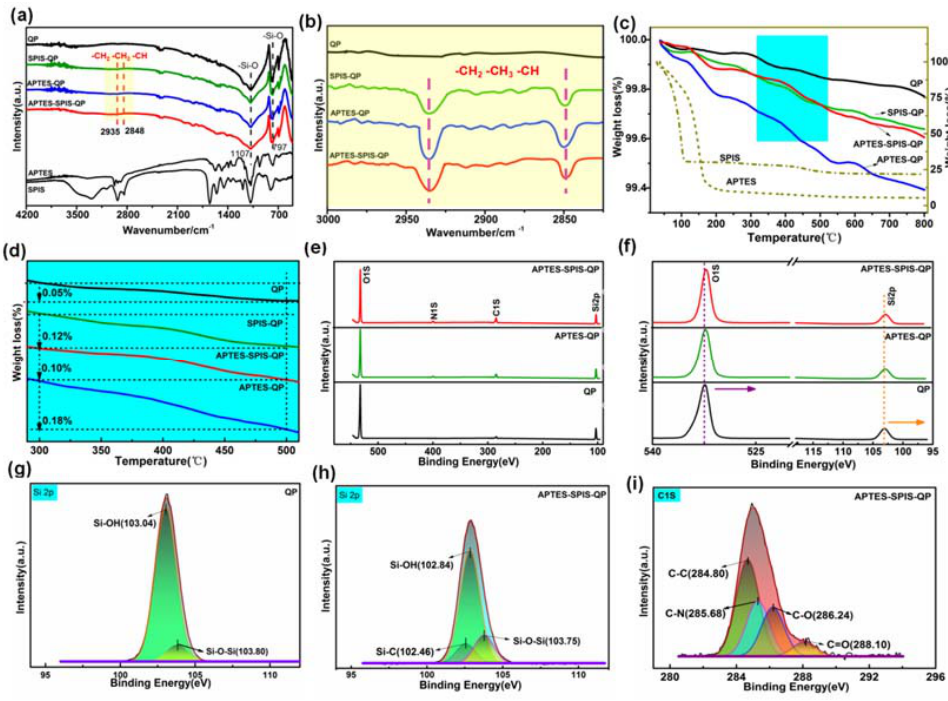
Figure 4. Surface coating analysis of the as-obtained samples. ( a ) FTIR spectra of the as-obtained samples. ( b ) Magnified images showing the absorption peaks of the organic functional groups, such as alkyl, –CH 2 , and –CH 3 of the as-obtained samples. ( c ) TGA curves of the as-obtained samples. ( d ) Magnified TGA curves at 300–500 ◦ C. ( e ) XPS spectra of the as-obtained samples. ( f ) Magnified spectra showing the O 1s and Si 2p peaks. ( g ) Si 2p spectrum of the pristine sample. ( h ) Si 2p spectrum of the sample modified by 2% APTES and 1% SPIS. ( i ) C 1s spectrum of APTES ‐ and SPIS ‐ modified sample.